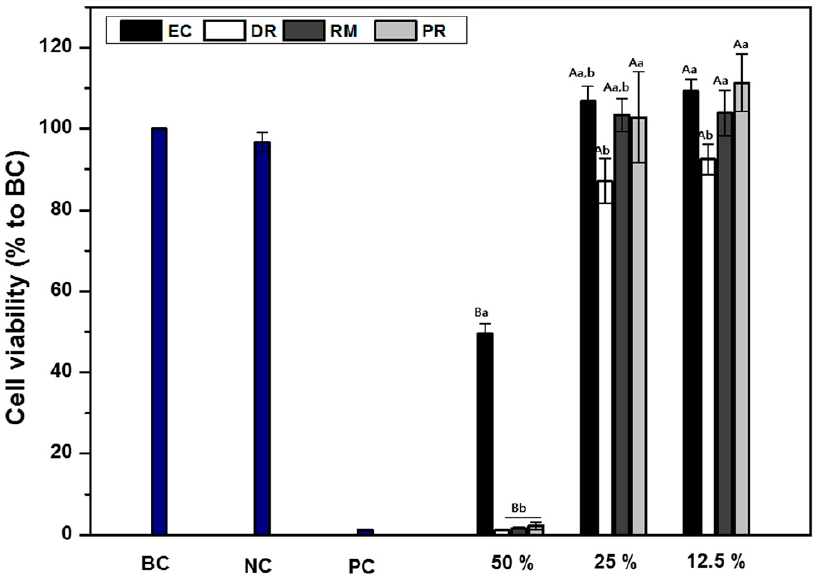
Figure 3. Cytotoxicity with the extracts from commercial MTA as measured by the MTT assay. The same uppercase letters indicate statistically significant differences in the dilution factor within each material ( p < 0.05). The same lowercase letters indicate statistically significant differences within each MTA group ( p < 0.05). BC, blank control; NC, negative control; PC, positive control.